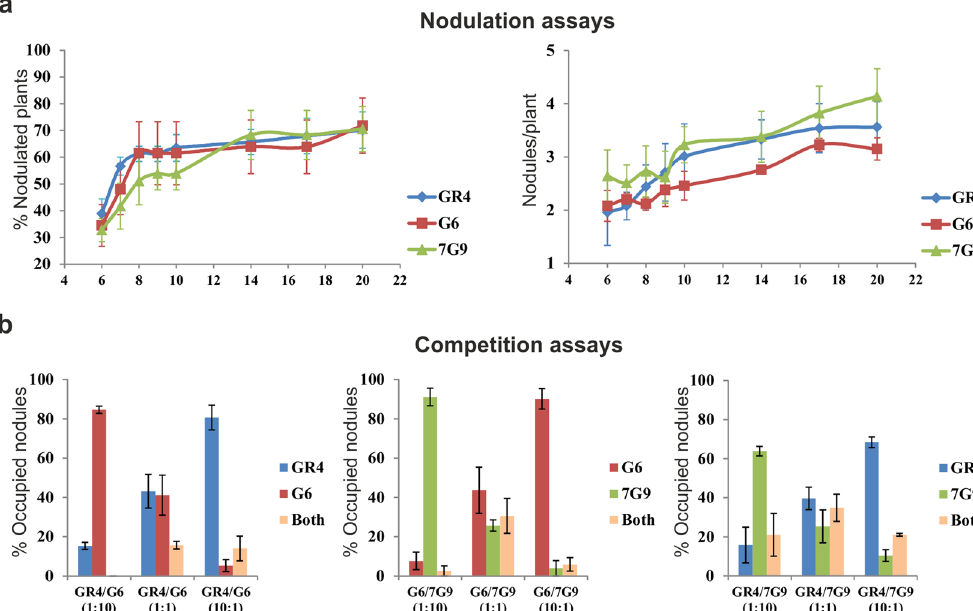
Figure 7. Nodulation and competition assays on M. sativa . ( a ) Nodulation assays. Quantification of the number of nodules per plant and the percentage of nodulated plants obtained with each of the isolates indicated and the GR4 reference strain. The x-axis indicates the number of days post-inoculation. ( b ) Competitive nodule occupancy assays. Bacterial cells were co-inoculated at ratios of 1:1, 1:10 and 10:1 and their presence within the nodules was determined by PCR, with the use of specific primers to distinguish them (Supplementary Table